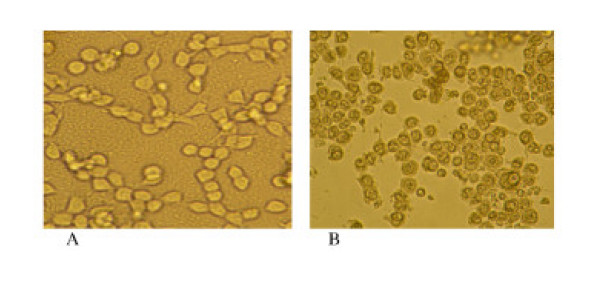
Photomicrographic changes in human adenocarcinoma cells, LNCaP, characteristic of apoptosis; becoming more evident after 48 hr treatment with 1:500 dilution of cytoregR. A: control LNCaP cells without treatment and incubatingfor 48 hr; cells showing normal morphological characteristics of proliferation. B: Light photomicrograph of LNCaP cells after 48 hr treatment; showing cell shrinkage, nuclear condensation and fragmentation -classical characteristics of apoptosis.